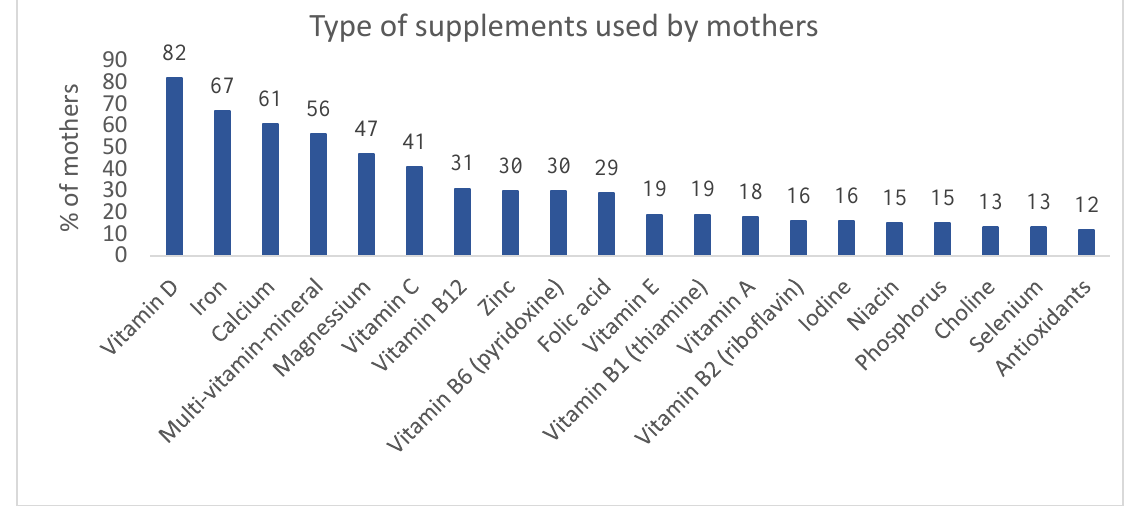
Figure 2. Type of supplements used by mothers.